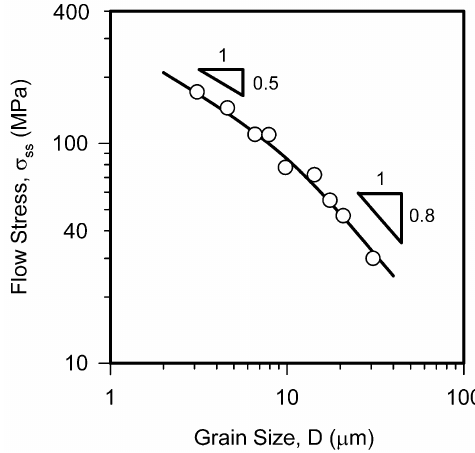
Figure 5. The relationship between the steady-state flow stress and dynamically recrystallized DRX grain size as obtained in hot compressions of a high-Mn steel.